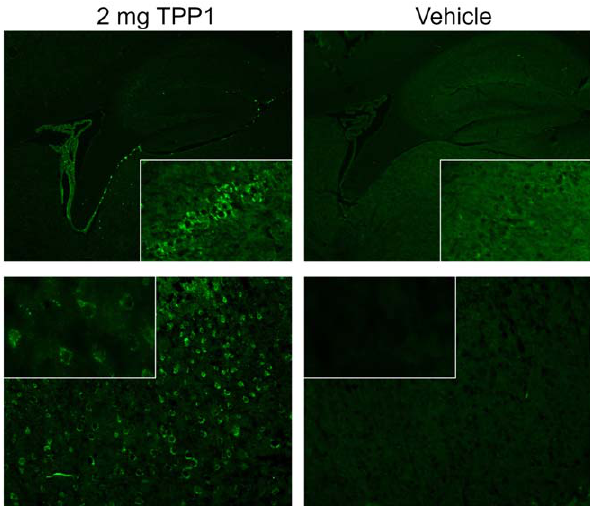
Figure 8. Immunostaining for TPP1. Tpp1 ( 2 / 2 ) mice were administered unmodified enzyme or vehicle alone via tail vein injection and tissues collected after 24 hours. Tissue processing and immuno- staining was conducted as described previously [33]. Top Panels show the choroid plexus and hippocampus (original magnification 4 6 ) with inset showing hippocampal CA2 neurons (20 6 ). Bottom Panels show cerebral cortex layer 2/3 (20 6 magnification) with inset showing select neurons (60 6 ).